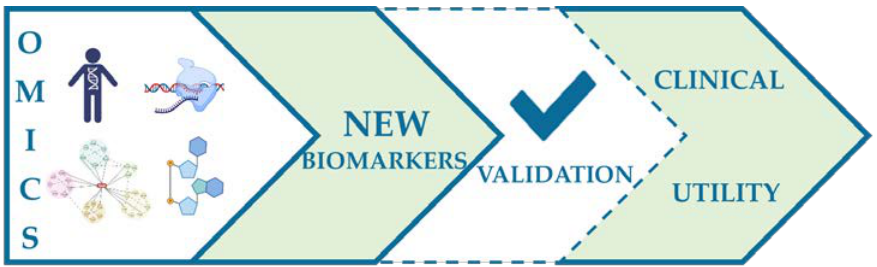
Figure 1. Single- and multi-omic workflow (e.g., genomics, transcriptomics, proteomics, and metabolomics) from new biomarker discovery to new biomarker applications in the clinic.